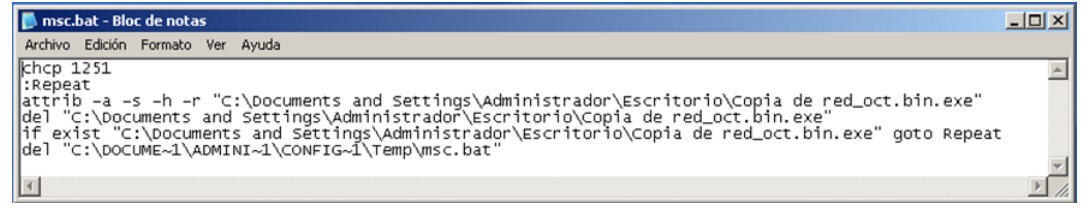
Figure 15. File ‘msc.bat’.